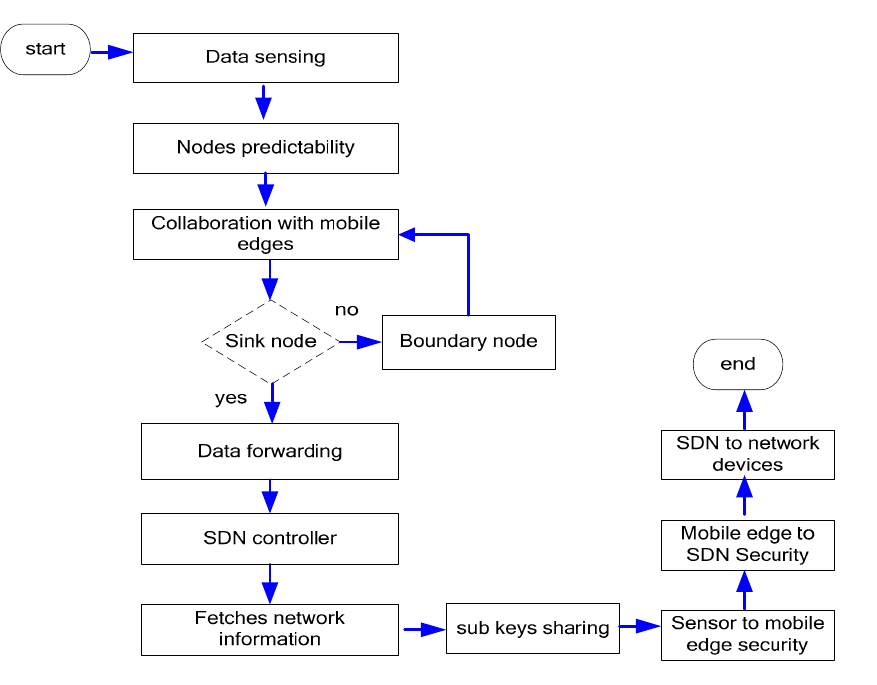
Figure 2. Flow chart of the proposed model.